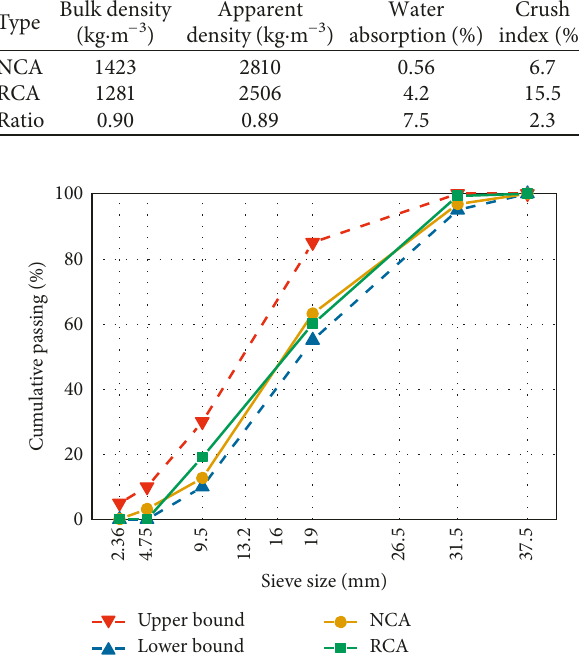
Figure 1: Grading curves of the coarse aggregates (reproduced from Hu et al. [24] (under the Creative Commons Attribution License/public